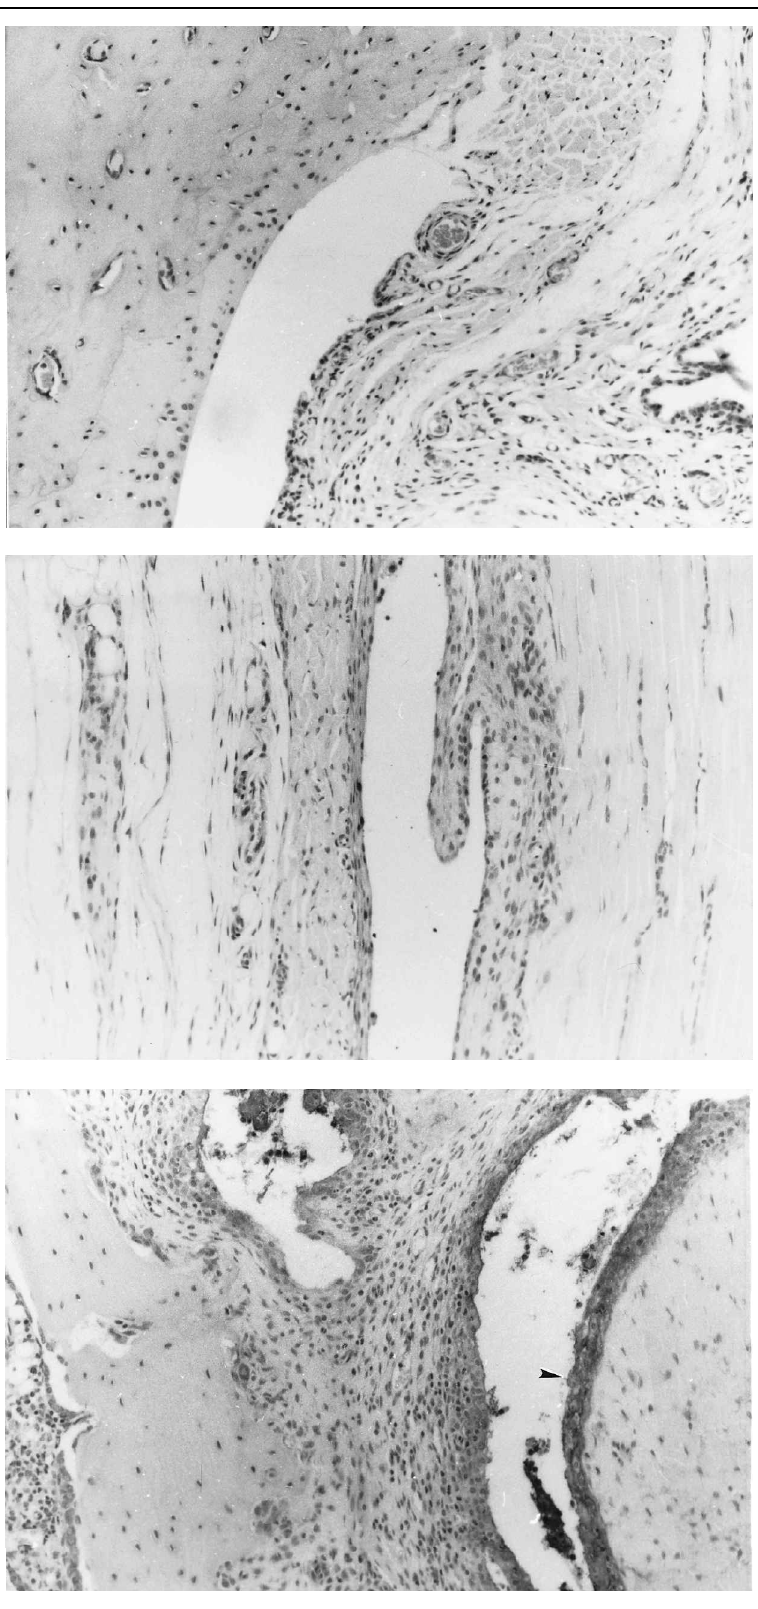
FIG. 5. Photomicrographs showing the detection of tumor necrosis factor-alpha (TNF a ) by immunocytochemical (ICC) methods in the synovial tissue of experimental arthritic joints. Tissue was stained with VECTASTAIN ABC system and counterstained with hematoxylin. (a) Photomicrograph of a ‘control’ ankle joint which was repeatedly injected with saline. For the purpose of ruling out non-specific binding, sequential cuts of ‘control’ ankle joints were subjected to either anti-TNF a or normal rabbit IgG. (b) Photomicrograph of a joint injected with a single injection of PG-APS and harvested at the same time as the joints pictured in (a) and (c). (c) Distribution of TNF a positive cells in synovial tissue from rat ankle joints that were primed with PG-APS and re-injected with enzymatically active myeloperoxidase